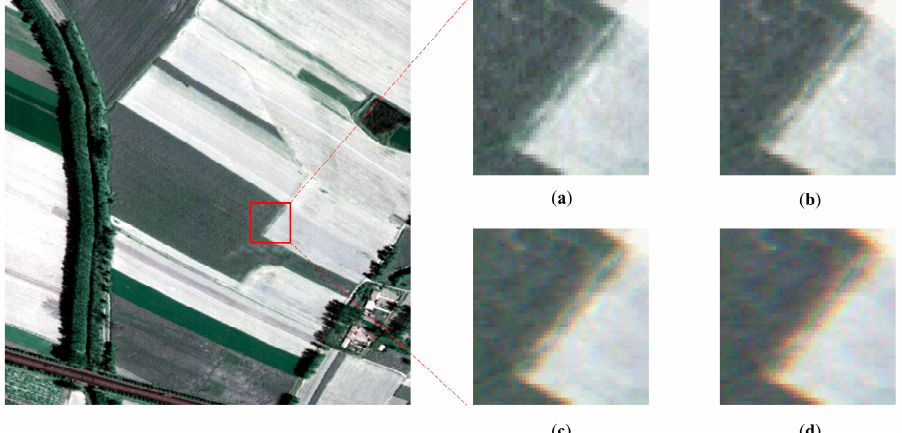
Figure 8. Pseudo-color sub-images with k of ( a ) 0; ( b ) 0.01; ( c ) 0.03; ( d ) 0.05.